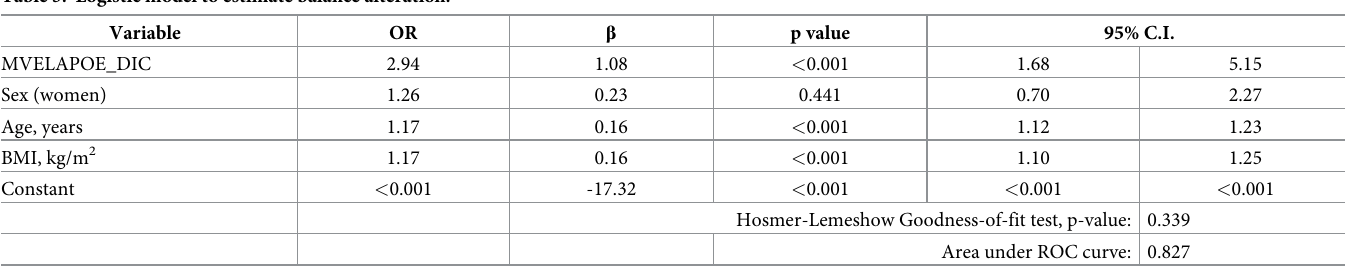
Table 3. Logistic model to estimate balance alteration.